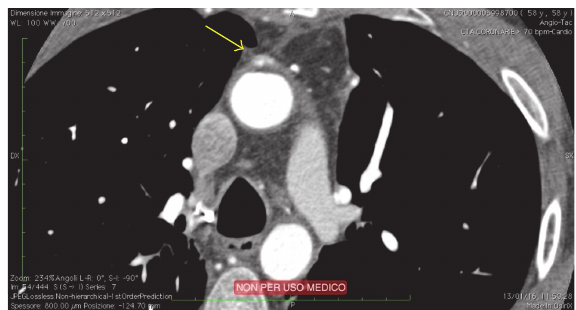
Figure 1: Thoracic CT scan of the patient two months after OPCAB. The yellow arrow points at a localized anterior wall disruption on ascending aorta, at the site of aortic punching.